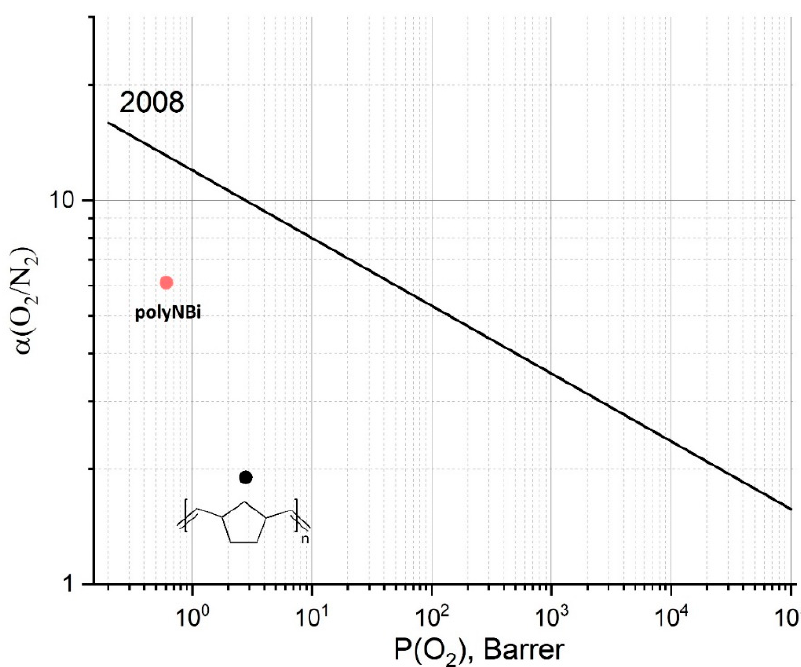
Figure 5. Robeson plot of O 2 /N 2 separation performance for polyNB (black) and polyNBi (red).